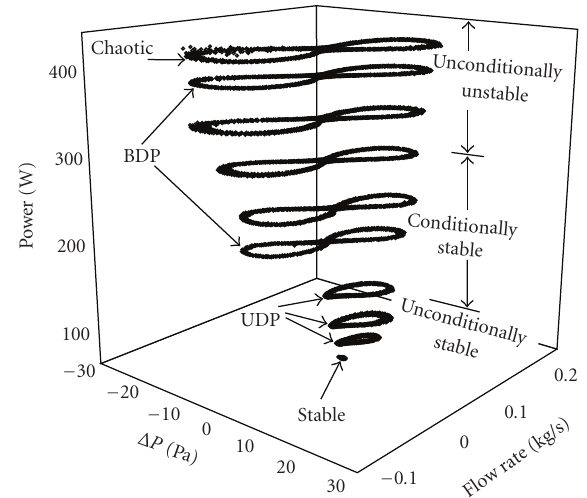
Figure 4: Unstable oscillatory regions in single-phase